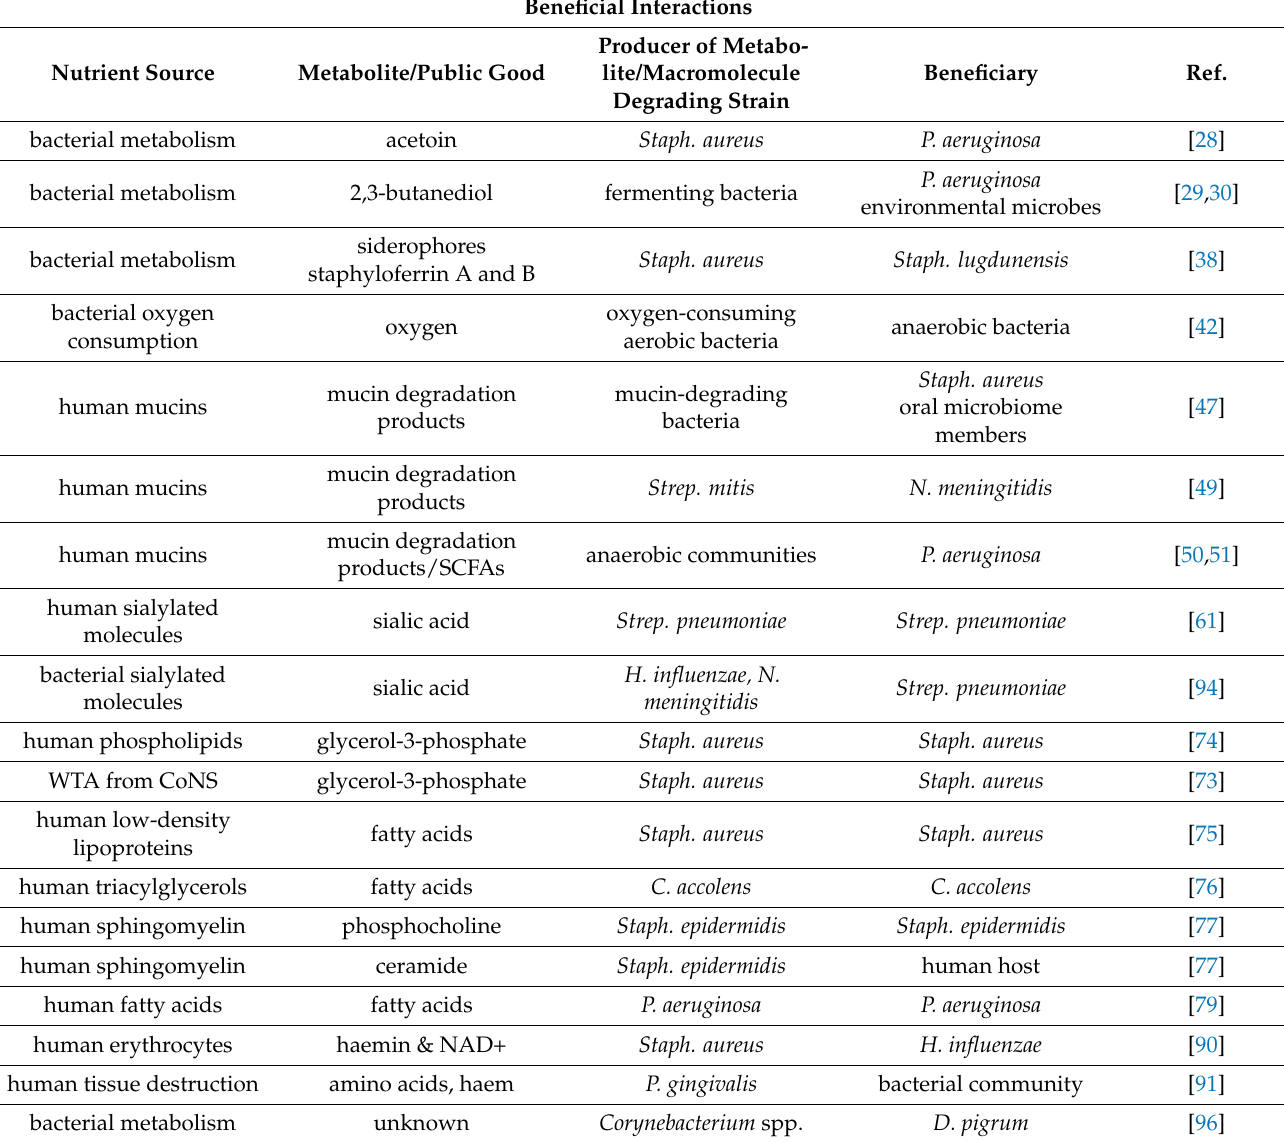
Table 1. Overview of metabolic interactions in the nasal, respiratory tract and skin microbiome. Metabolites or public goods, their producer, as well as species profiting or being inhibited, are